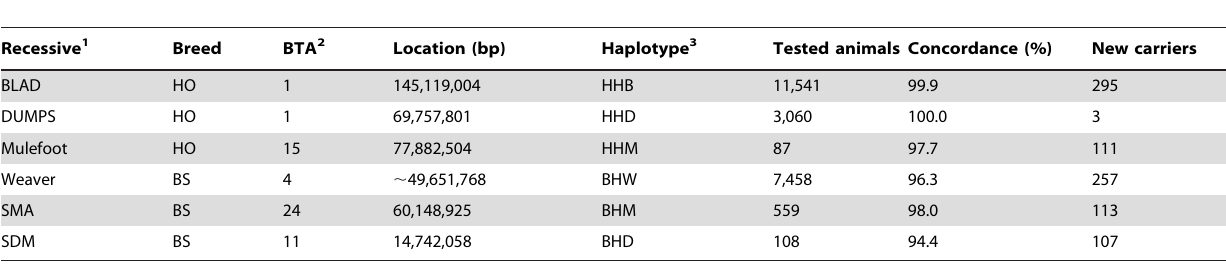
Table 3. Haplotype vs. official test results for 6 known recessive conditions in Holstein (HO) and Brown Swiss (BS) cattle.